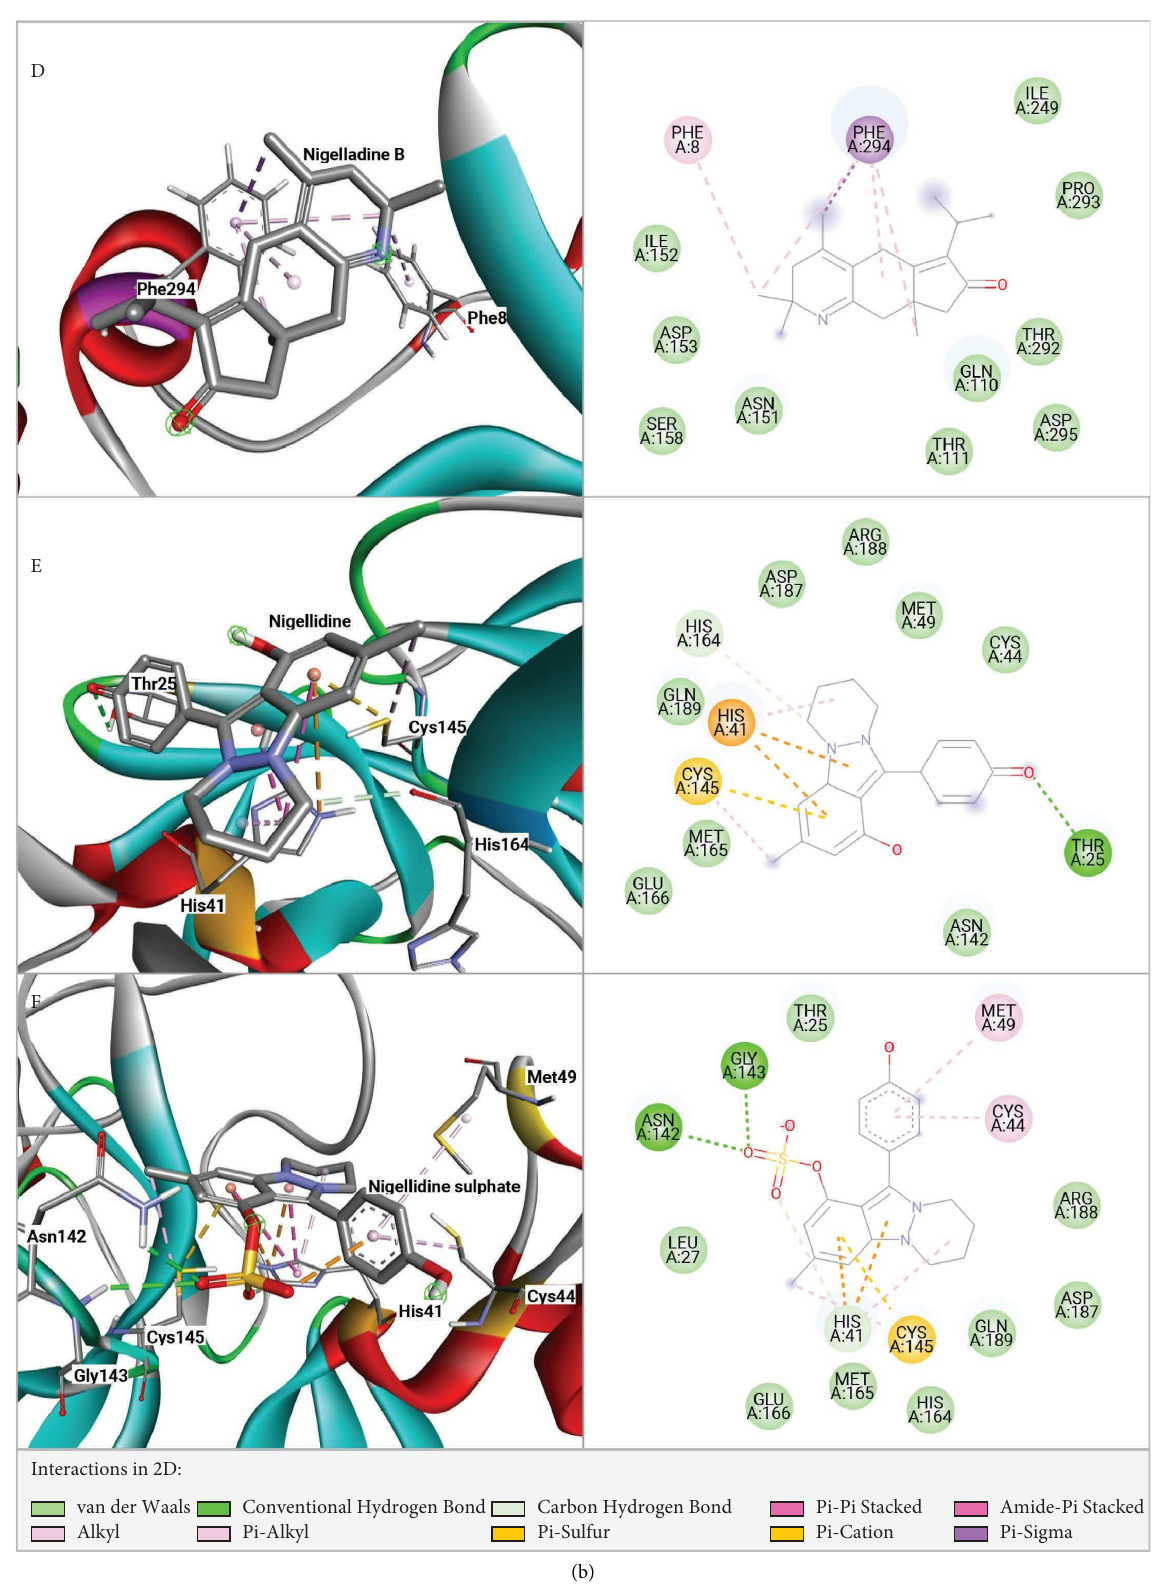
Figure 2: Docked conformations (3D and 2D) of M pro with (A) dithymoquinone, (B) kaempferol, (C) Nigelladine A, (D) Nigelladine B, (E) Nigellidine, and (F) Nigellidine